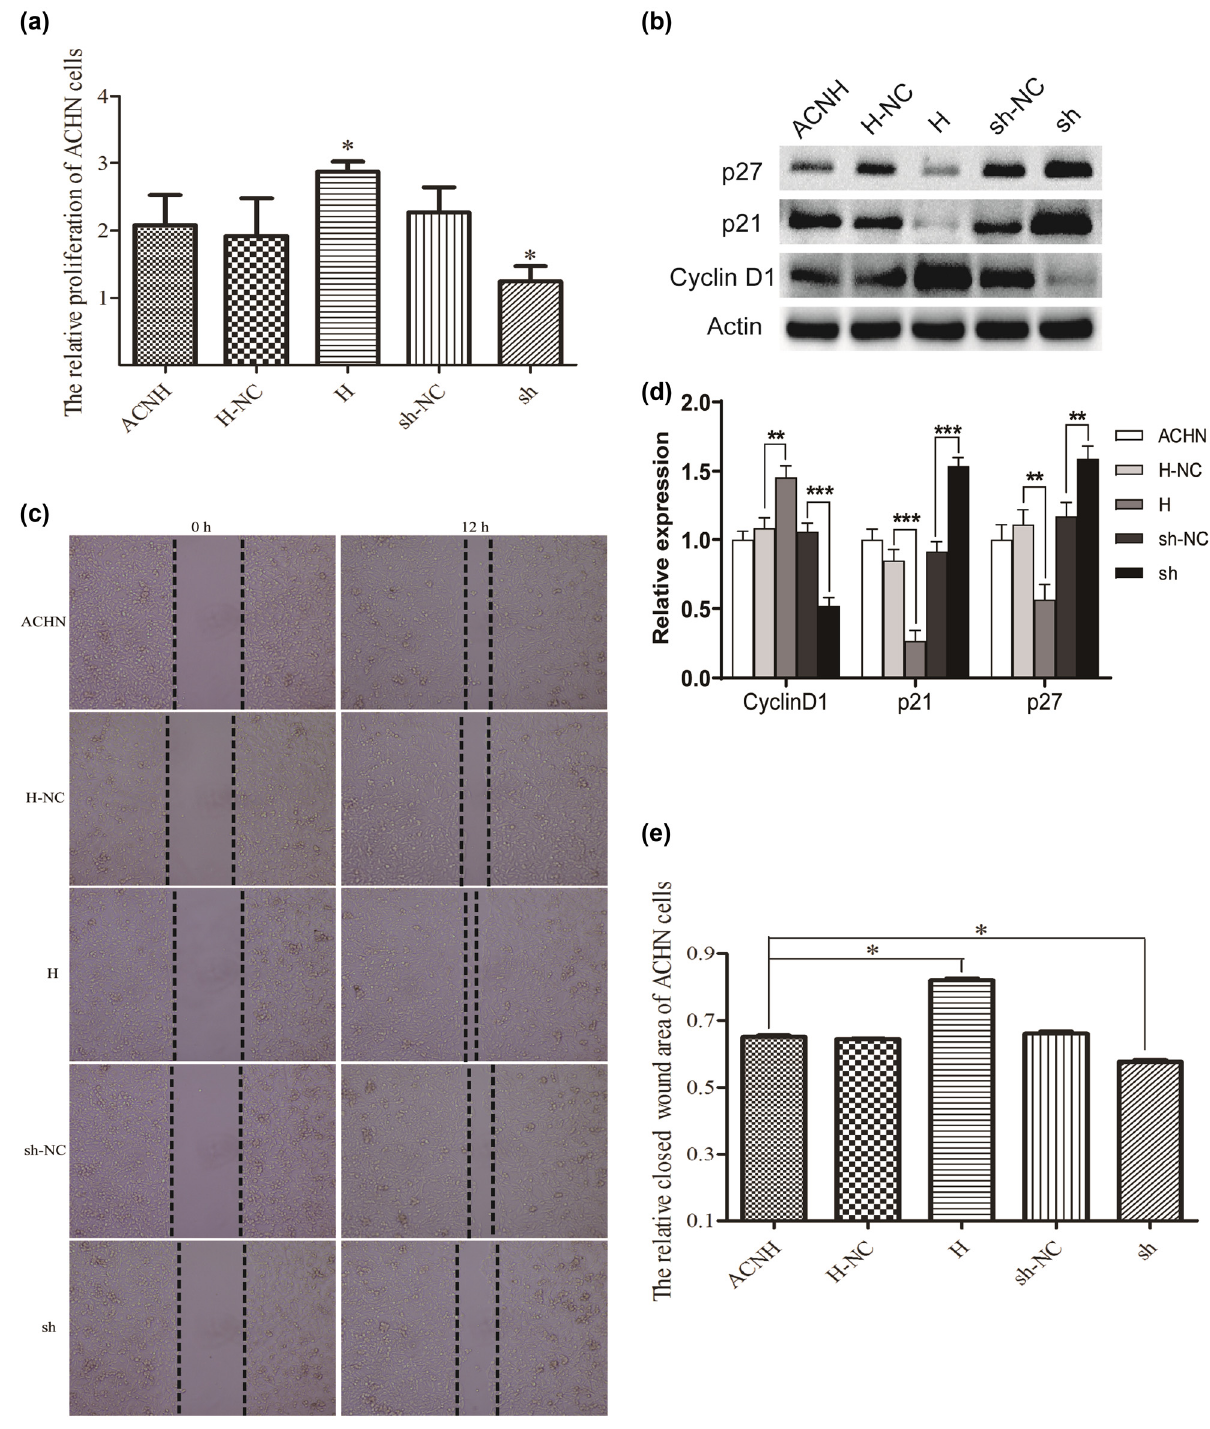
Figure 2: Trim24 promoted the proliferation and migration in ACNH cells. ( a ) Cell proliferation was estimated by the CCK8 assay. ( b ) The expression of p21, p27, and Cyclin D1 was detected using western bolt. ( c ) Gray scale was analyzed using Image J software. ( d ) The migration abilities were detected by wound healing assay. After transfection for 48 h, cells were photographed ( 100 × magni fi cation ) . ( e ) The closed wound area was analyzed using Image J software. * P < 0.05, ** P < 0.01, and *** P <